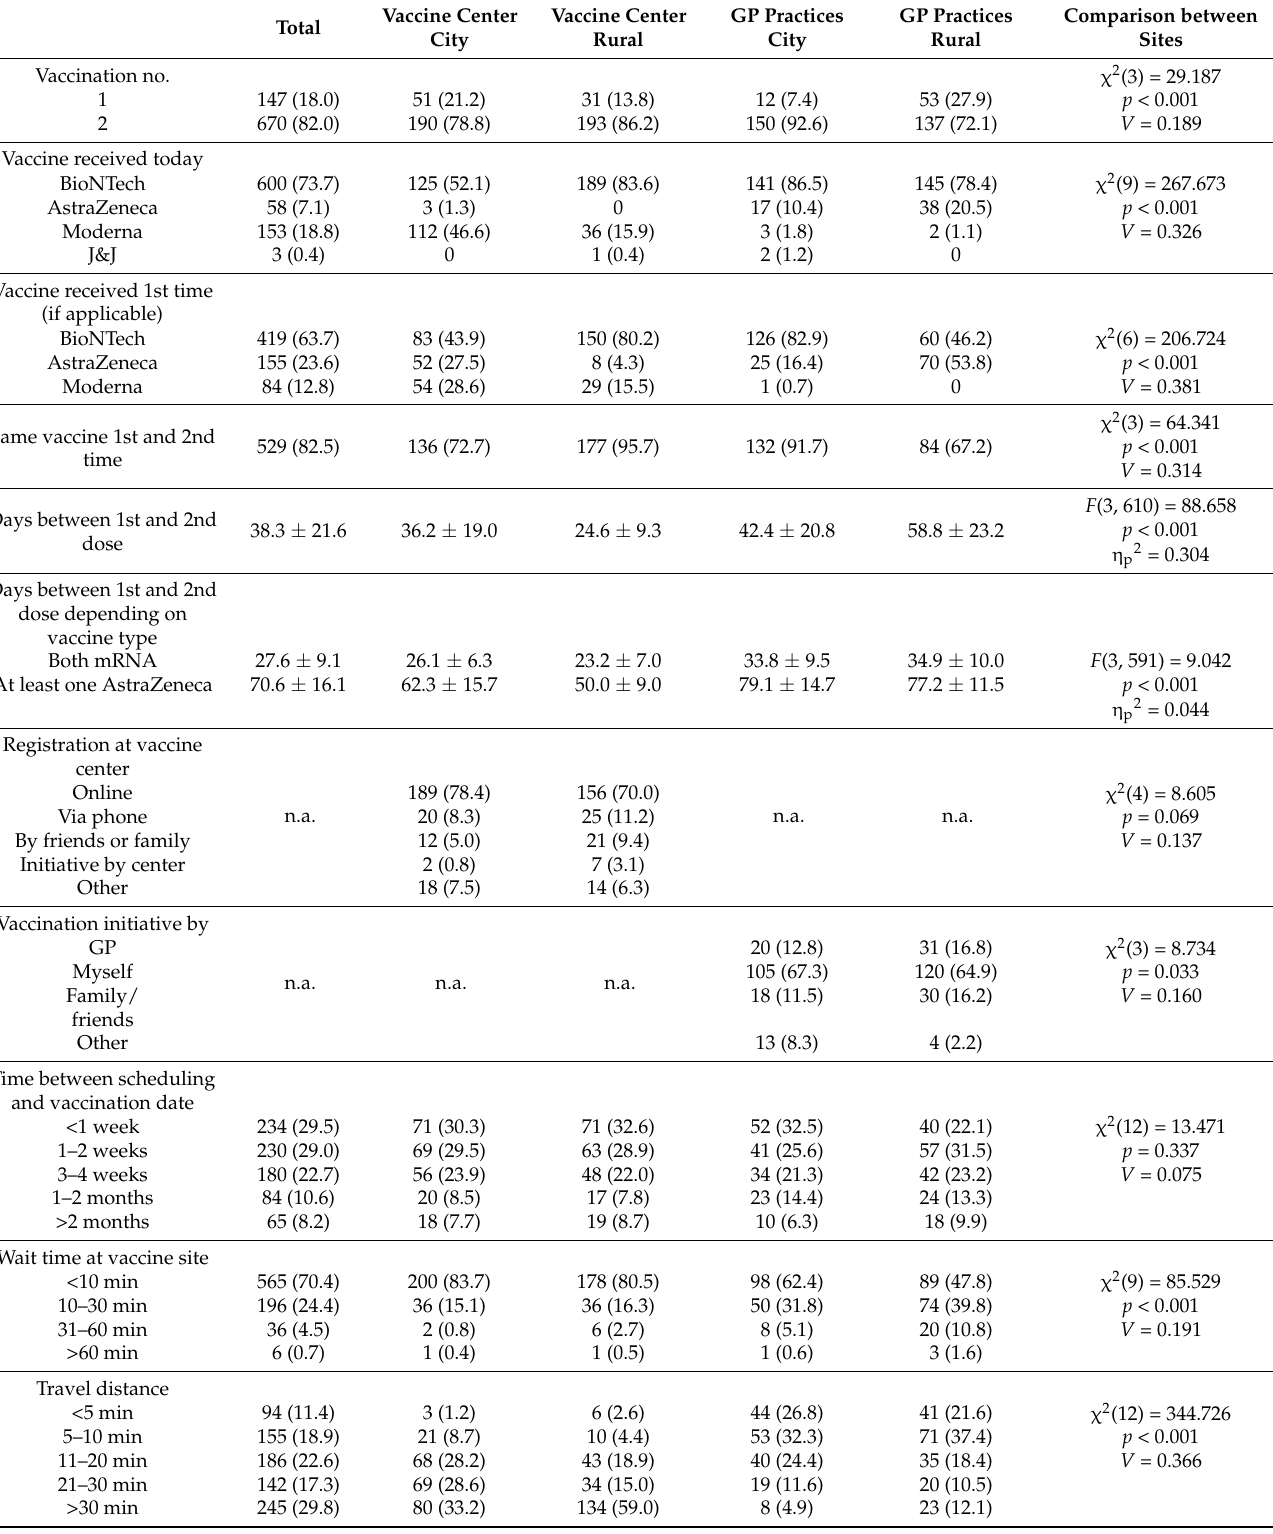
Table 2. Access to vaccines and comparison between vaccine